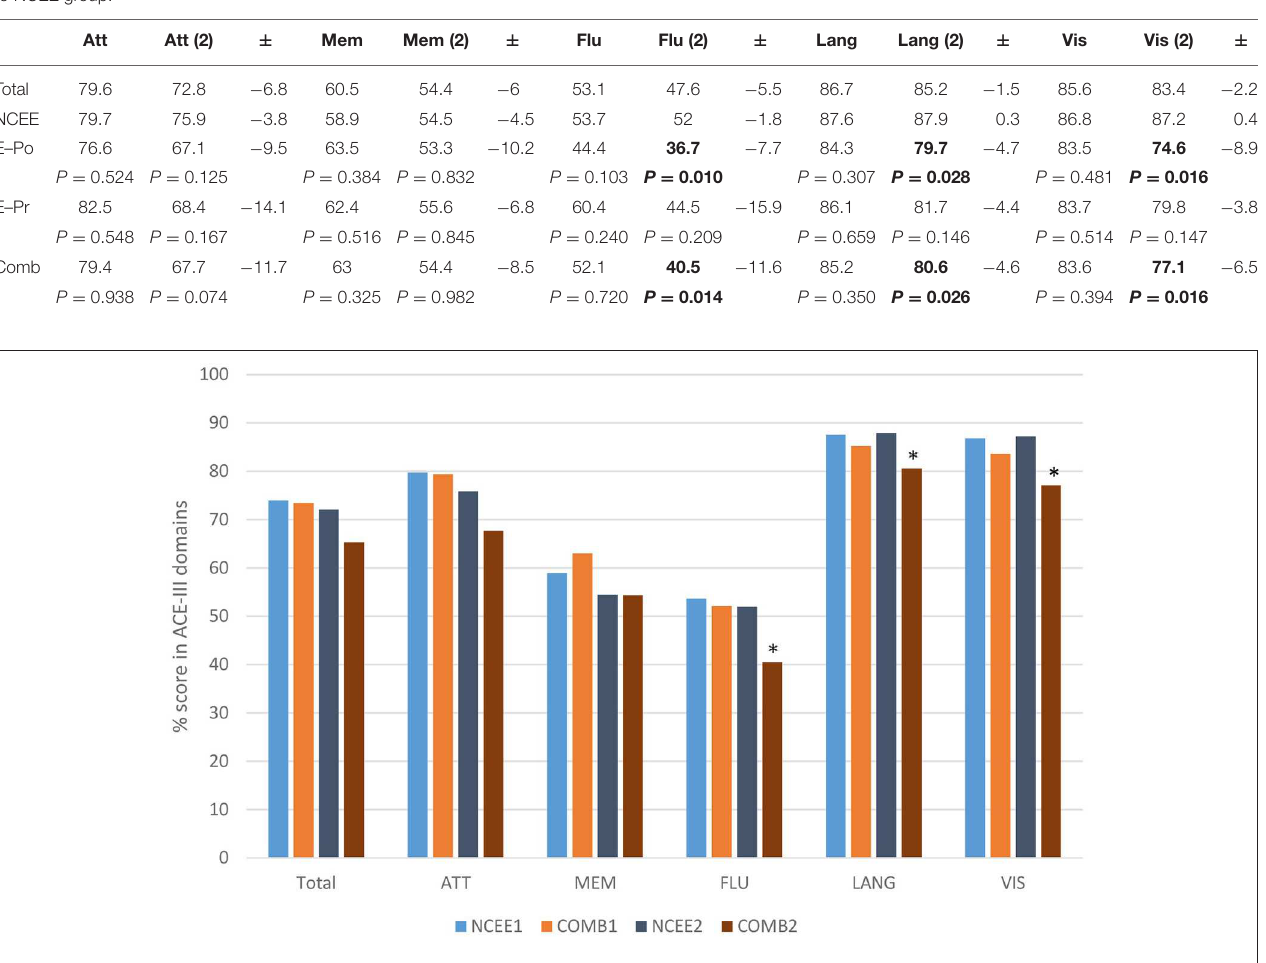
FIGURE 1 | Comparison of ACE-III total score and sub-domain scores at baseline and 12-month follow-up (COMB vs. NCEE), *indicates significant difference ( p < 0.05) when compared to NCEE.